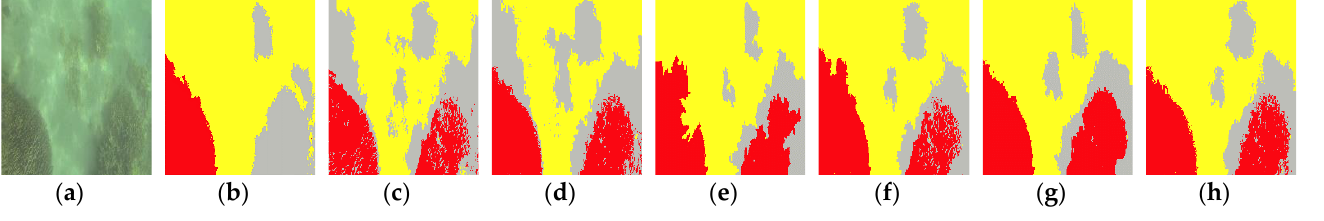
Figure 20. Validation tests of the proposed segmentation algorithms using low illuminated and high contrast blue coral image (15) from Figure 16 as example of three categories: ( a ) original image; ( b ) ground truth image; ( c ) KM result; ( d ) KMAc result; ( e ) FFCr result; ( f ) FRCr result; ( g ) OSCr result; ( h ) KMCr result. Red: blue corals, gray: corals, and yellow: sediments.